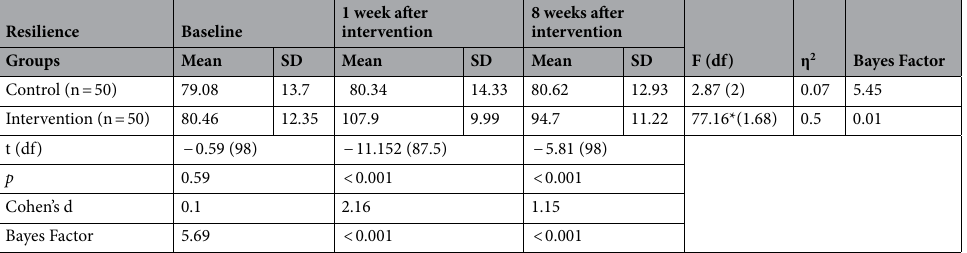
Table 3. The mean scores of resilience in the study groups. * p < 0.001.